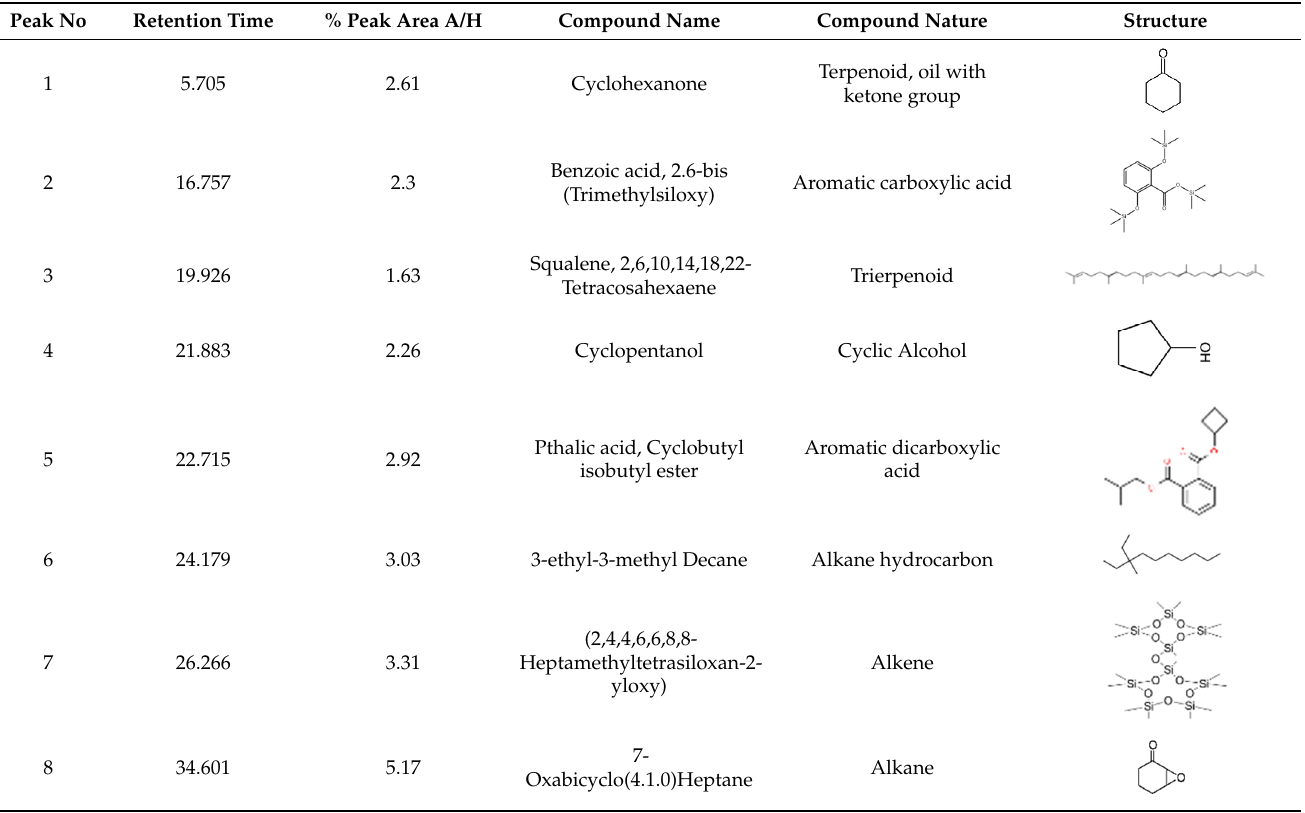
Table 7. GCMS analysis of F3 column fraction of S. glauca.